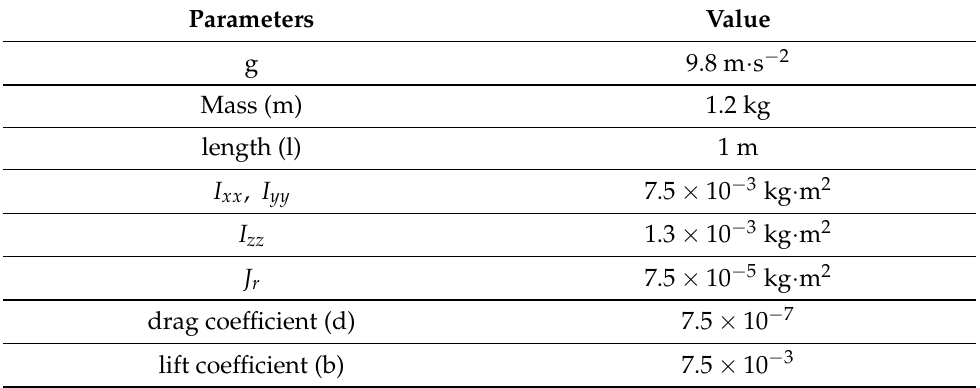
Table 1. Simulation Parameters.